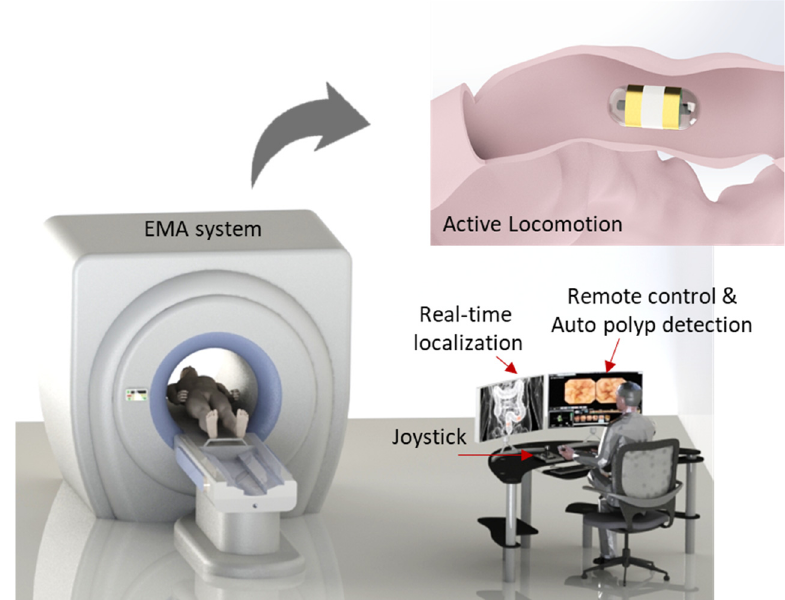
Figure 1. Concept drawing of the overall system.